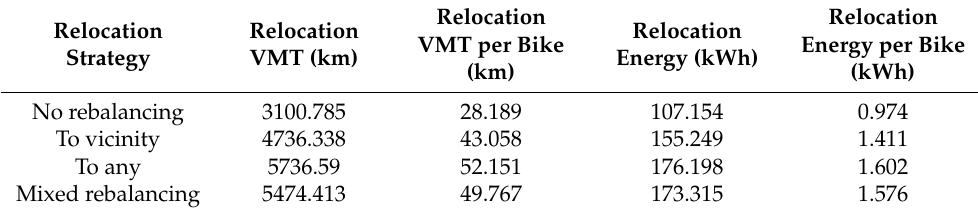
Table 2. Average KPIs for the different rebalancing